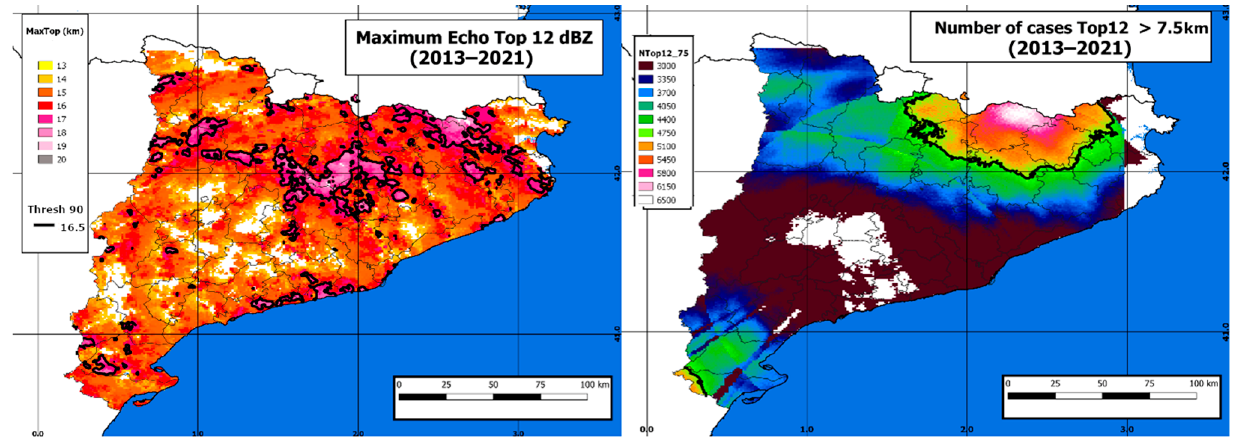
Figure 3. ( Left ): Maximum Echo Top height registered during the period 2013–2021 for the TOP12. The solid black lines delimit the regions with values over 90% concerning the maximum. Areas with white color indicate that maximum TOP12 did not exceed 13 km at any time during the period of study. ( Right ): Cumulative map of cases of TOP12 being equal or larger than 7.5 km for the same period. The solid black lines delimitate the regions with values over 75% for the maximum.